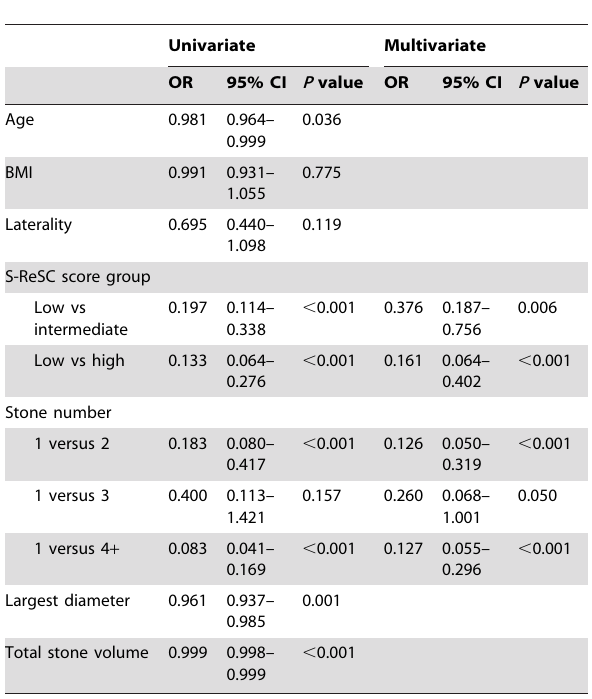
Table 4. Uni- and multivariate logistic regression analyses for predictors of stone-free